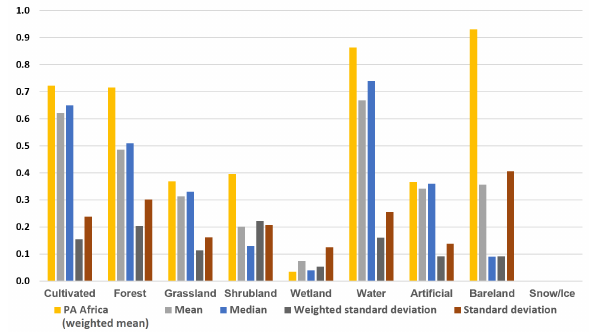
Figure 2. Summary statistics of PA